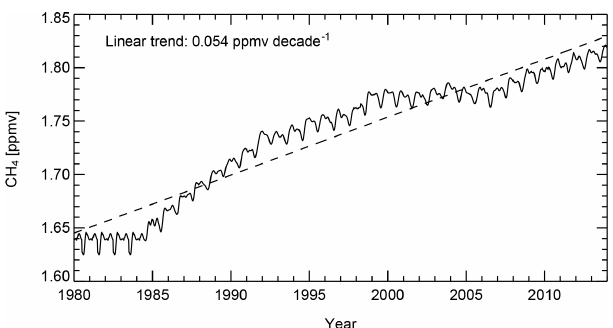
Figure B1. Temporal variations from 1980–2013 in the global mean methane mixing ratio prescribed at the model lower boundary, i.e., the hybrid vertical coordinate ζ equal to